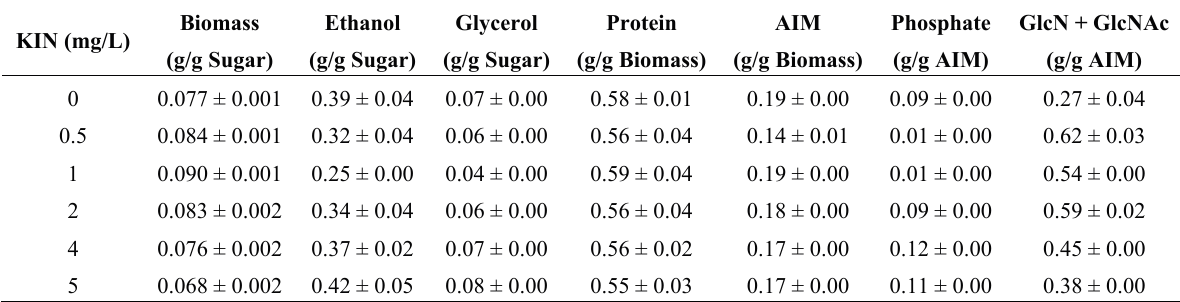
Table 2. The biomass, ethanol, glycerol, protein, AIM, phosphate, and sum of GlcN and GlcNAc in the presence of kinetin